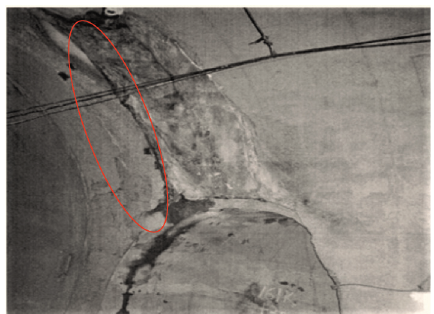
Figure 1: Lining crack of tunnel in chi-chi earthquake [4]. Table 1: Investigation results of seismic damage for tunnels during Wenchuan earthquake.